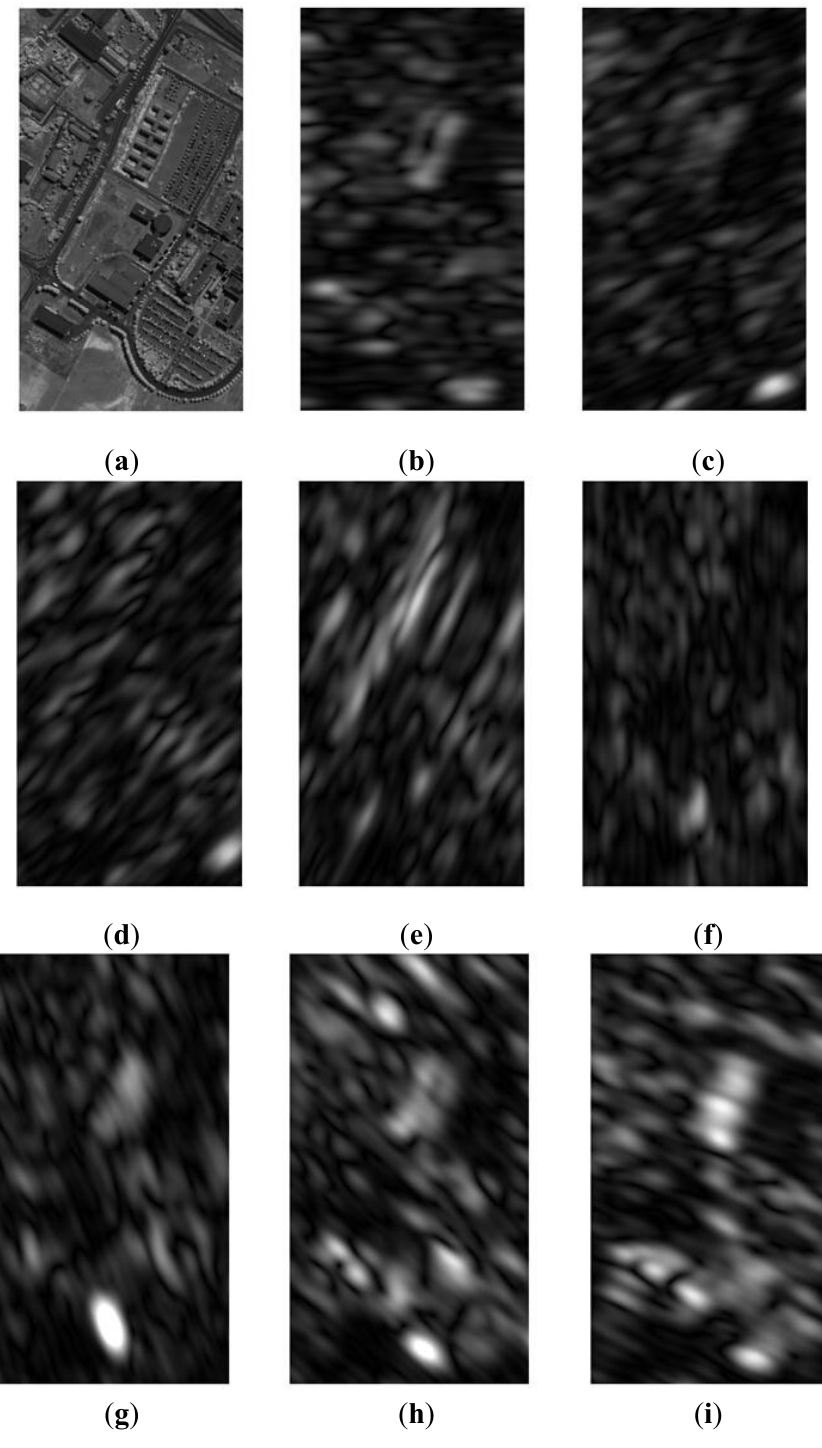
Figure 3. ( a ) Band 95 of the University dataset. ( b )–( i ) Eight Gabor feature images corresponding to eight orientations of the